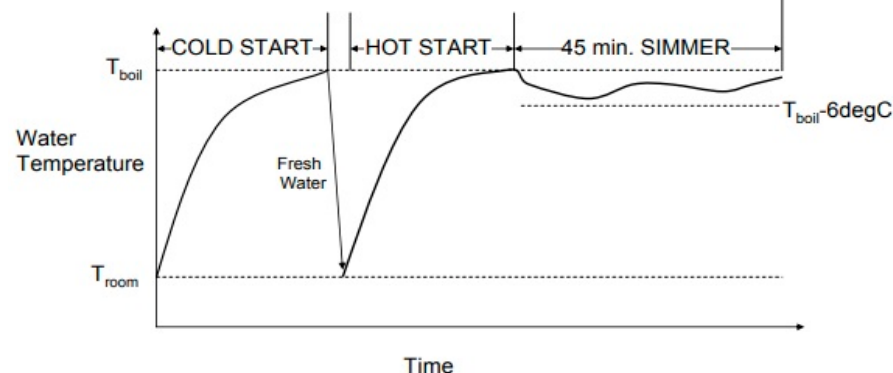
Figure 4. Graphical representation of the Water Boiling Test (WBT) phases (Source: [28]).